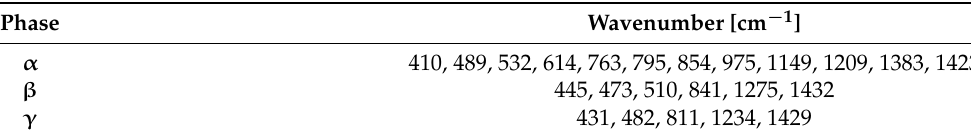
Table 5. Characteristic peaks of α , β , γ -phases for